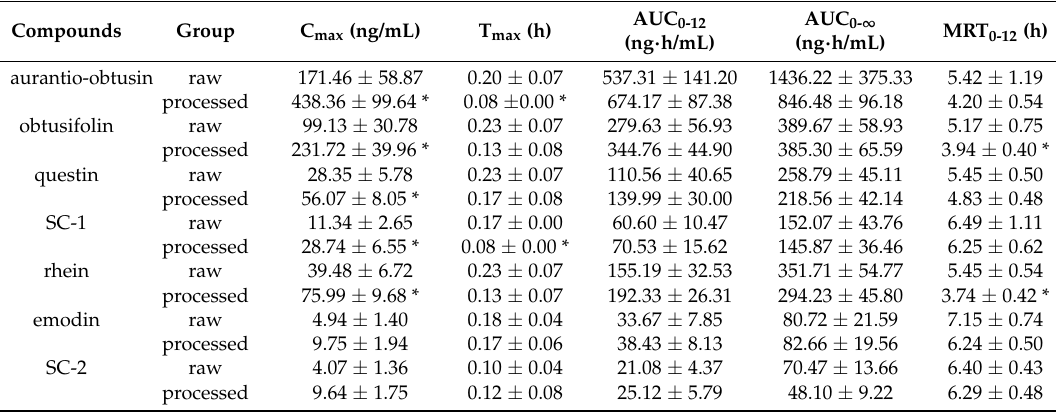
Table 5. Pharmacokinetic parameters of the seven analytes after oral administration of R-SC and P-SC extract ( n = 6, mean ± SD).